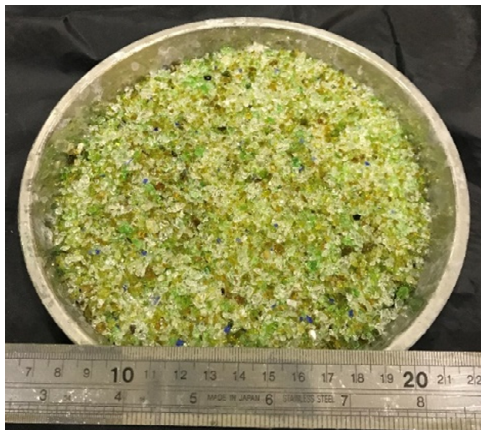
Figure 3. Appearance of GA.